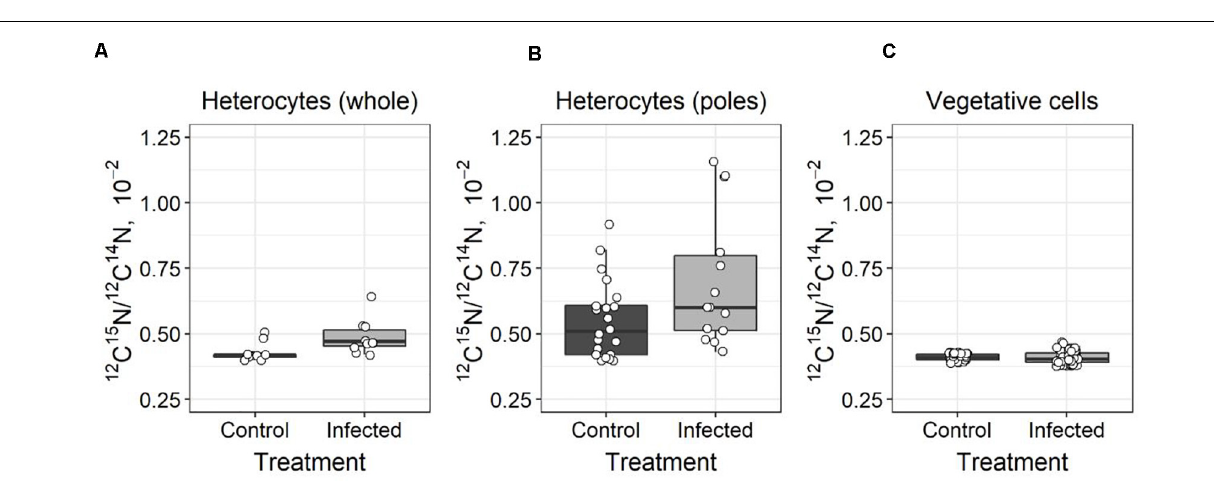
FIGURE 3 | Differences in 15 N enrichment in Aphanizomenon flos-aquae strain 2012/KM1/D3 heterocytes (whole cell– A , poles– B ) and vegetative cells (C) indicated as 12 C 15 N/ 12 C 14 N ratio (calculated from nanoSIMS analysis). The solid line within the box marks the mean, the boundaries of the box represent the standard error, and the whiskers above and below the box show the standard deviation from the mean. White circles represent the data value of each measured heterocyte (A,B) or vegetative cell (C)